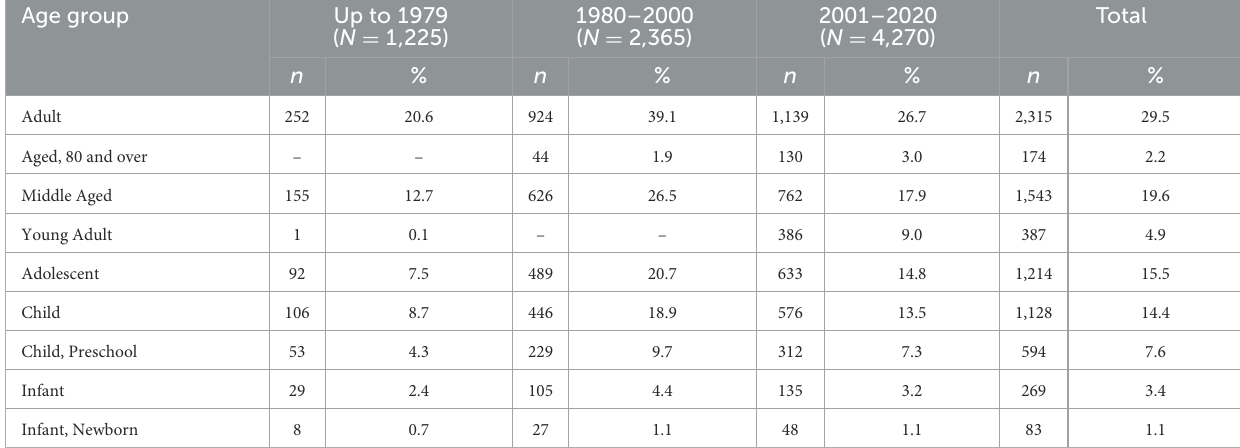
TABLE 7 MeSH descriptors related to age groups, assigned to scientific publications on cysticercosis and neurocysticercosis, indexed in